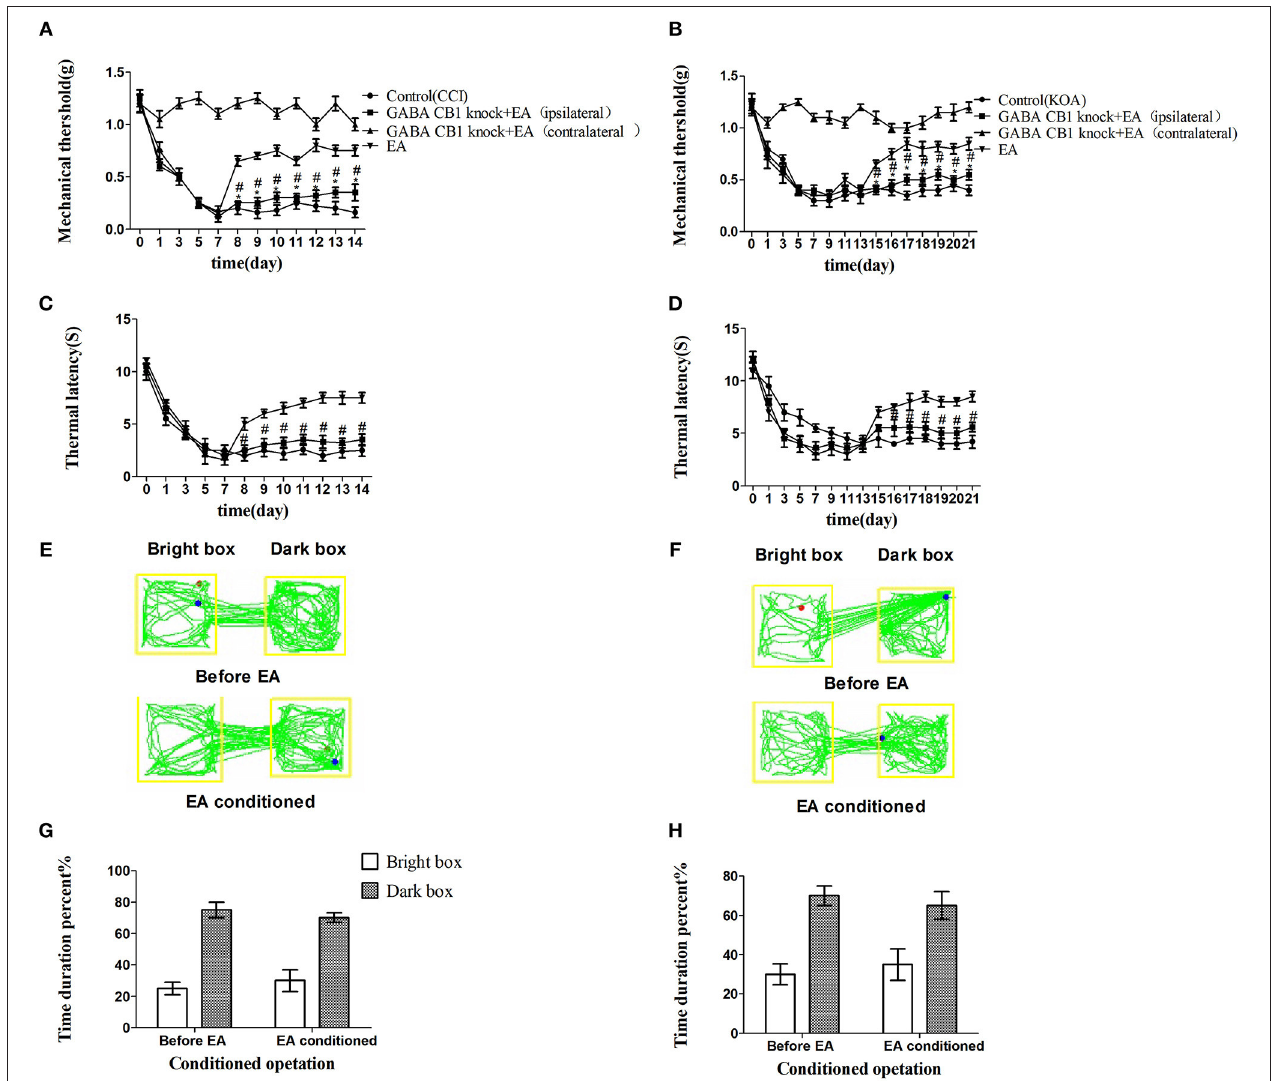
FIGURE 7 | Specifically knocking out CB1 receptor of GABAergic neurons abolished the EA effect on pain hypersensitivity. (A,B) Time course of tactile threshold in response to von Frey filaments. (C,D) The noxious heat stimulus (53 ◦ C) caused a change in the thermal thresholds. Tactile (A) and thermal (C) withdrawal thresholds changes in CCI mice. Changes in tactile (B) and thermal (D) withdrawal thresholds of KOA mice. Motion map of EA conditioned CPP test of CCI (E) and KOA mice (F) on the basis of specifically knocking out CB1 receptors of GABAergic neurons. G,H are statistical charts of motion trajectories. The rAAV-mDlx-CRE-WPRE-pA was injected into the right side of vlPAG of mCnr1 flox / flox 21 days before behavior test. Same volume of saline was injected into the right side of vlPAG of mCnr1 flox / flox as control group. EA (1mA and 0.1ms) at 2Hz was administered for 30min, once a day starting from 8th day to 14th in CCI model and starting from 15th day to 21th in KOA model. Control groups are CCI or KOA mice without EA treatment. Data are expressed as means ± SEM ( n = 5 in each group). In A–D , * p < 0.05, compared with the control group; # p < 0.05, compared with the model group; In G,H ,* p < 0.05, compared with the bright box time duration percent before EA; # p < 0.05, compared with the dark box time duration percent before